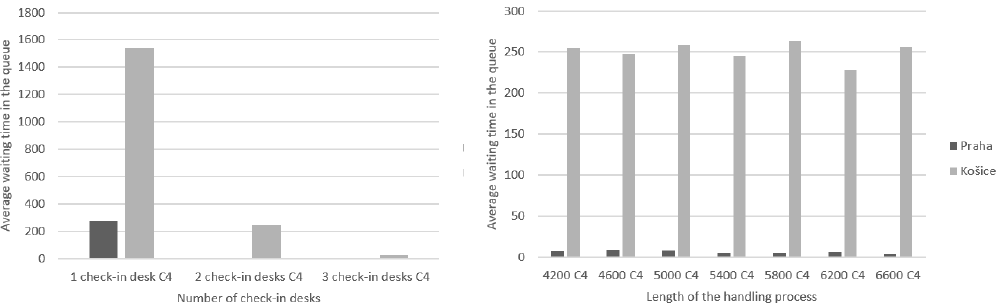
Figure 12. The effect of changing the number of check ‐ in desks and the length of handling time on C1.